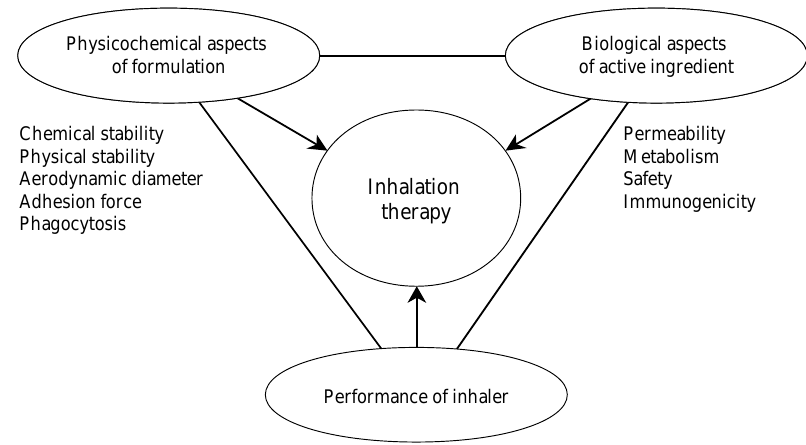
Fig. 1 Factors determining successful inhalation therapy with dry